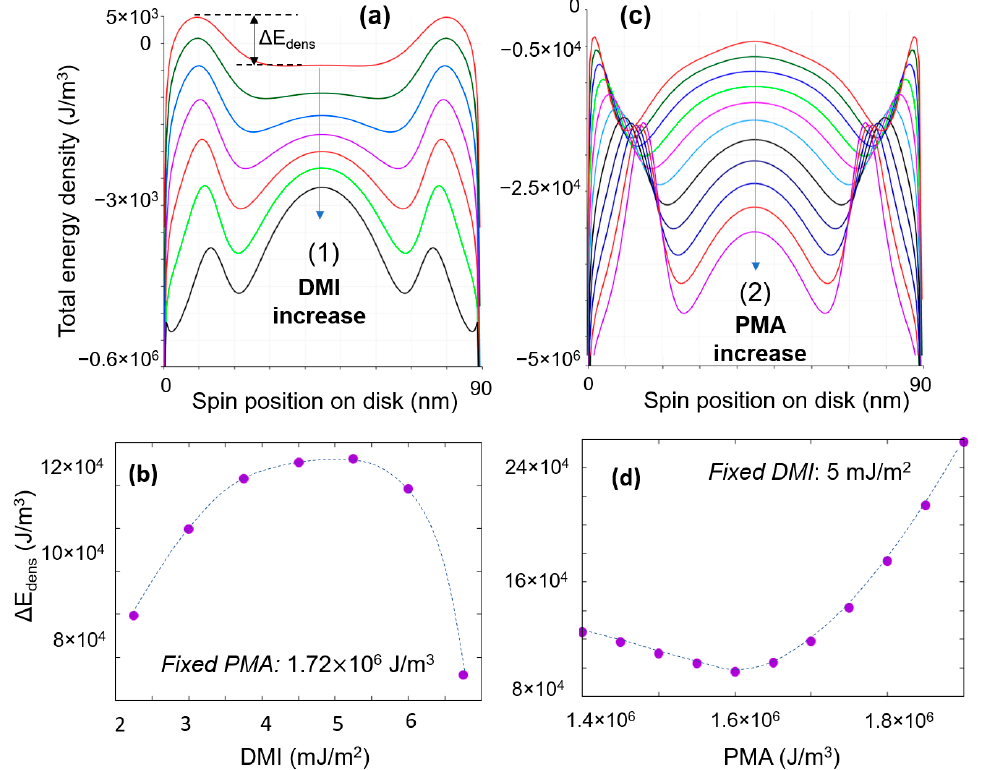
Figure 16. Total energy density line profile evolution with DMI and PMA for: ( a ) DMI increase at fixed PMA (along the line (1), Figure 15(a)) and ( b ) PMI increase at fixed DMI (line (2), Figure 15a). Evolution of the energy barrier ∆ E dens with the increase in the DMI ( c ) and PMA ( d